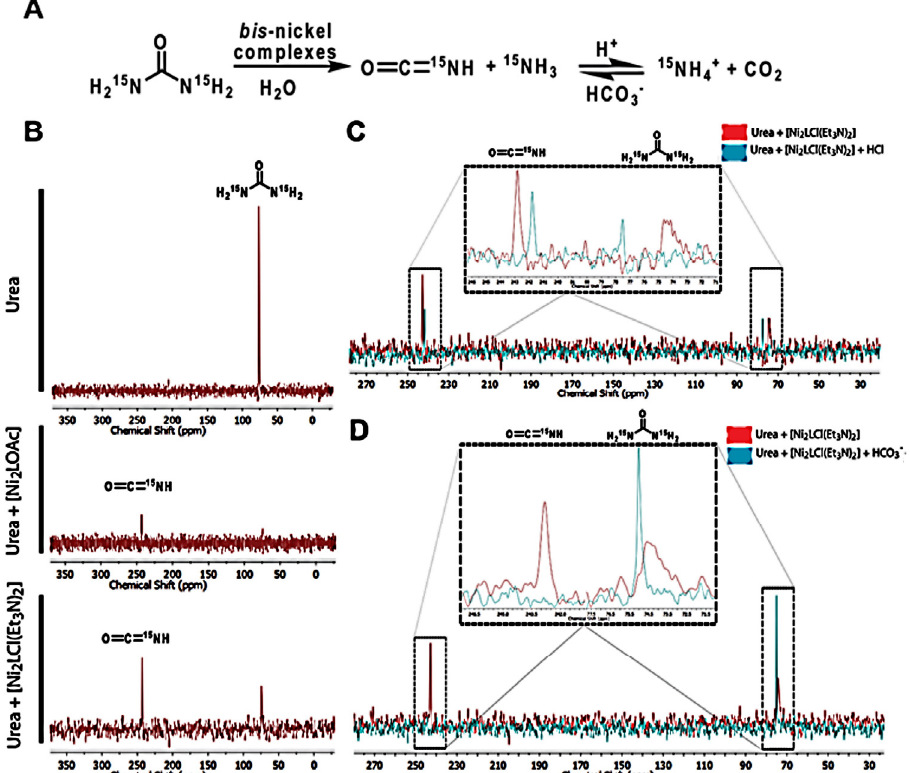
Figure 6. ( A ) Proposed reaction scheme of urea degradation by the bis-nickel complexes. ( B ) 15 N NMR spectra of urea before and after the addition of complexes (1) and (2). ( C ) 15 N NMR spectra of the reaction between urea and (2) complex before and after the addition of acid and ( D ) 15 N NMR spectra of the reaction between urea and (2) complex before and after the addition of bicarbonate to shift the equilibrium.